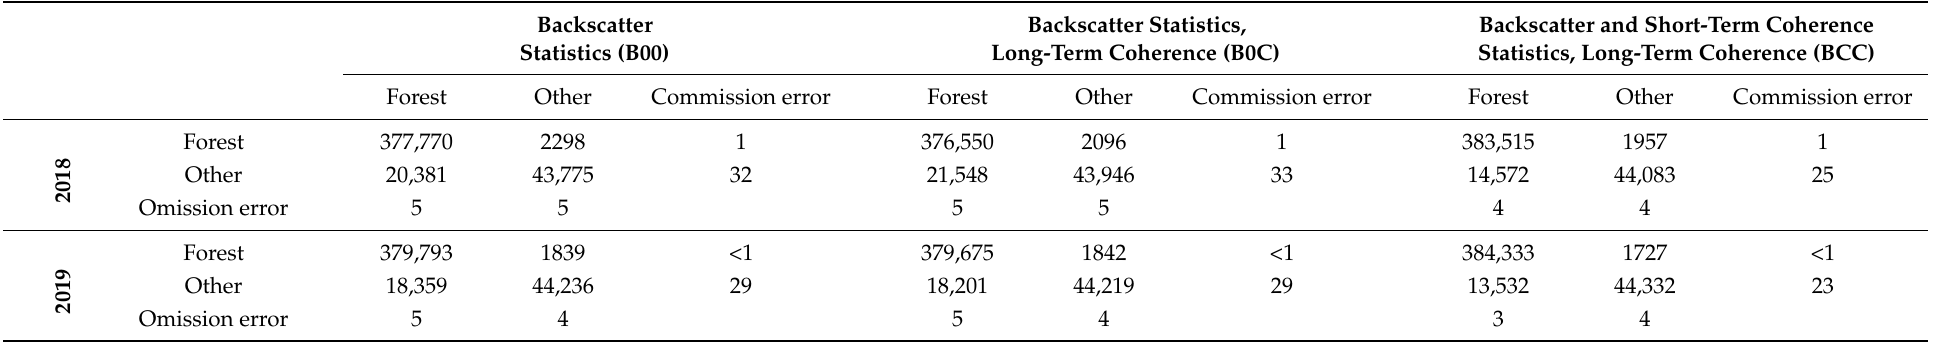
Table A4. Tropical site confusion matrices by year and feature set (Reference > columns; Classified > Rows) compared to the GEDI validation